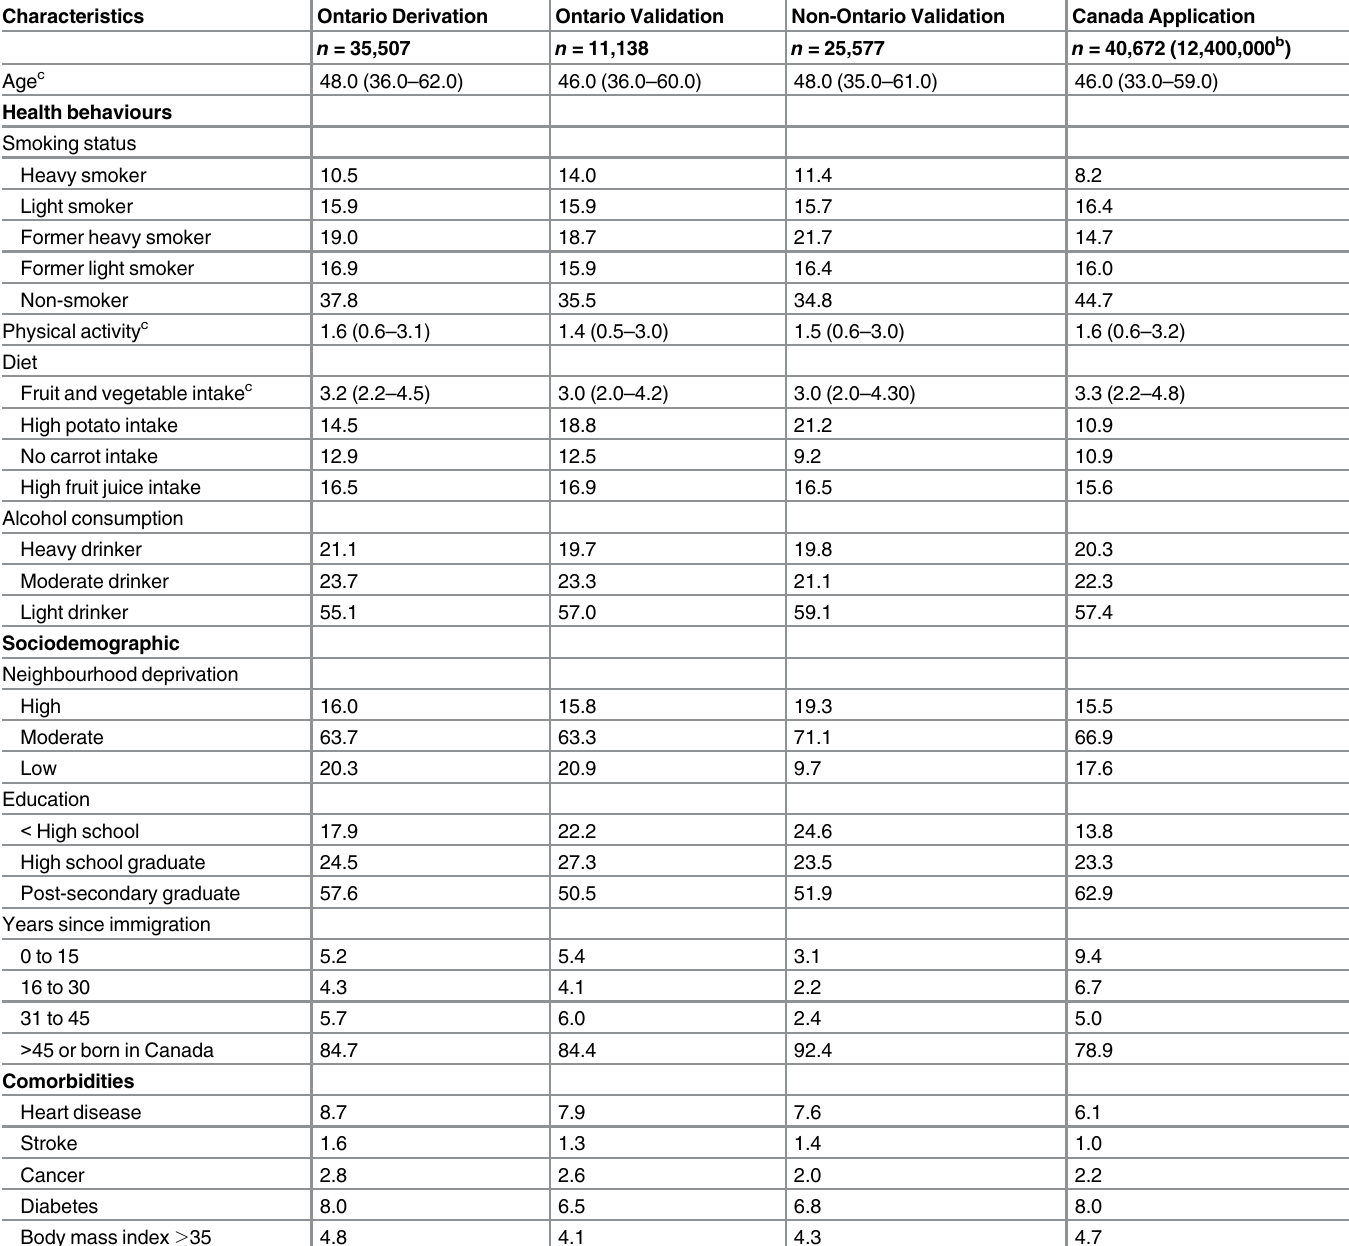
Table 2. Baseline characteristics of male study cohorts.